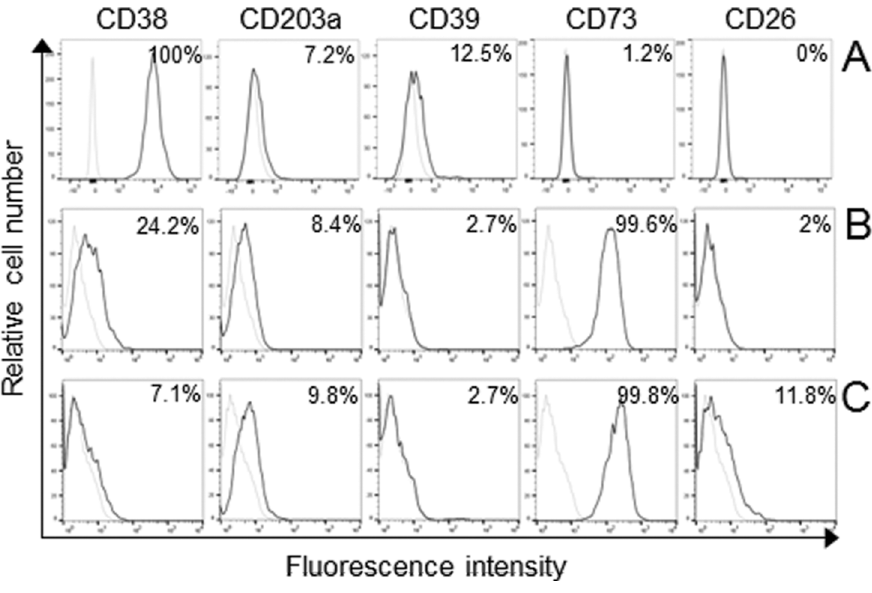
Figure 3. Expression of ectonucleotidases in cells in the BM niche. (A) Primary myeloma cells. (B) Stromal cells from cultures derived from BM aspirates from MM patients. (C) Ectonucle- otidases expression after osteoblastic differentiation of mesenchymal SCs from BM aspirates from MM patients. Black peaks: marker expression levels; gray peaks: isotype controls.